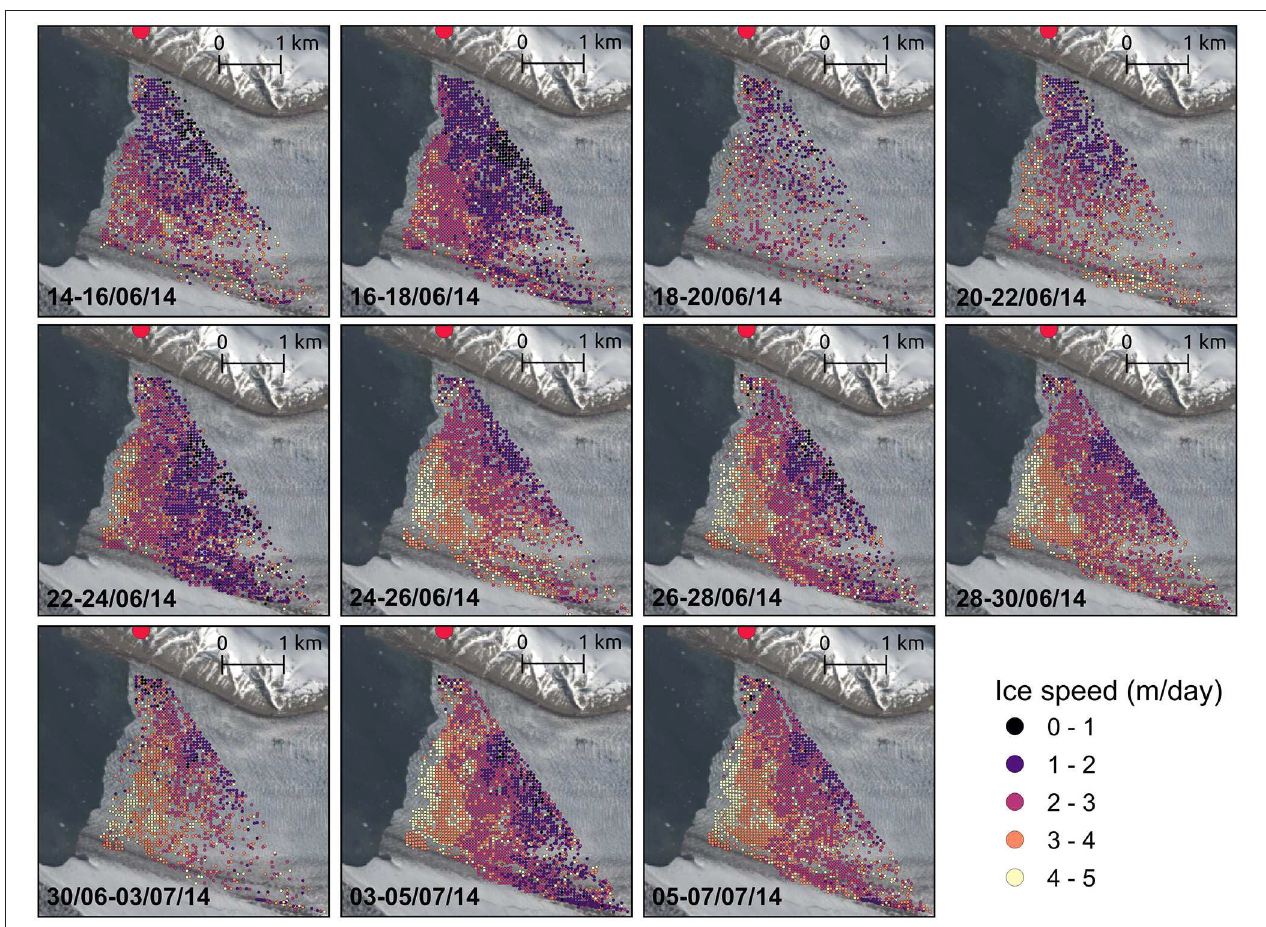
FIGURE 5 | An example of PyTrx’s dense feature-tracking and georectification functionality, with velocities determined from oblique time-lapse image pairs between 14 June and 7 July 2014 at Kronebreen camera KR2. Templates (represented here as points) were defined over a 50 × 50 m grid, which were matched between image pairs using normalized cross-correlation and filtered by correlation (i.e., templates were retained where the correlation of the match was above 0.8). The results have been plotted onto a coinciding Landsat 8 satellite image, with the red point denoting the location of the time-lapse camera (Kronebreen camera KR2). The sequence shows an early season speed-up at the terminus of the glacier, where velocities increase from an average of 2.5 m/day (14–16 June, first panel) to 4.7 m/day (5–7 July, last panel). A subset of this example (28 June to 7 July) is provided with PyTrx at